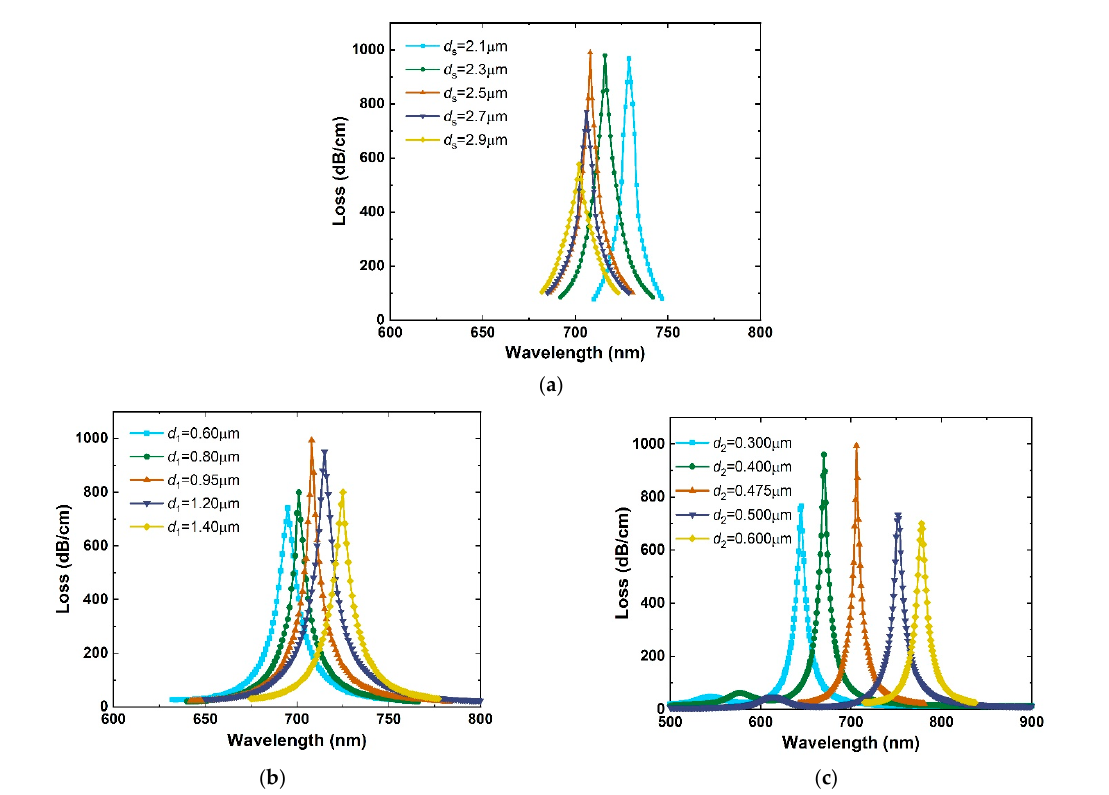
Figure 6. Response curve of confinement loss with ( a ) different polishing depths d s , ( b ) the diameter of large hole d 1 , and ( c ) the diameter of small hole d 2 , for n a = 1.33.